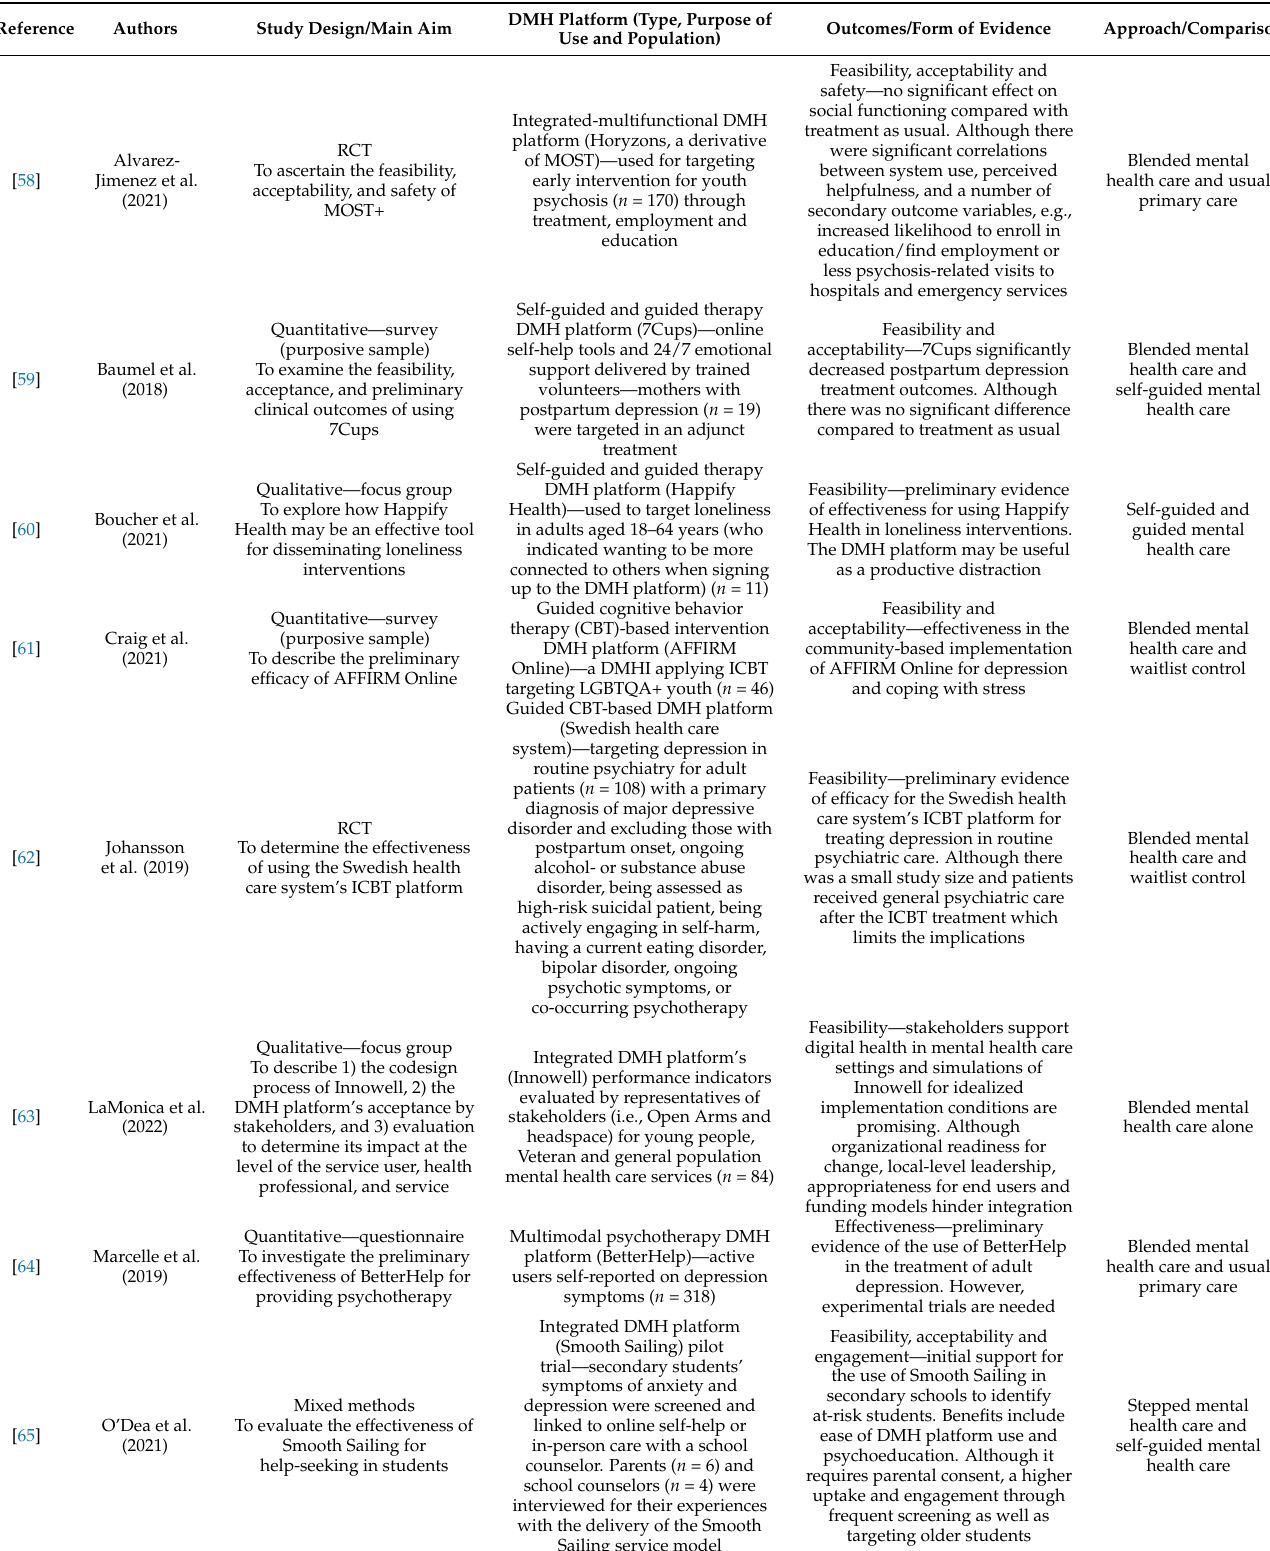
Table 1. Overview of empirical studies that focused on evaluation of the DMH platform/s